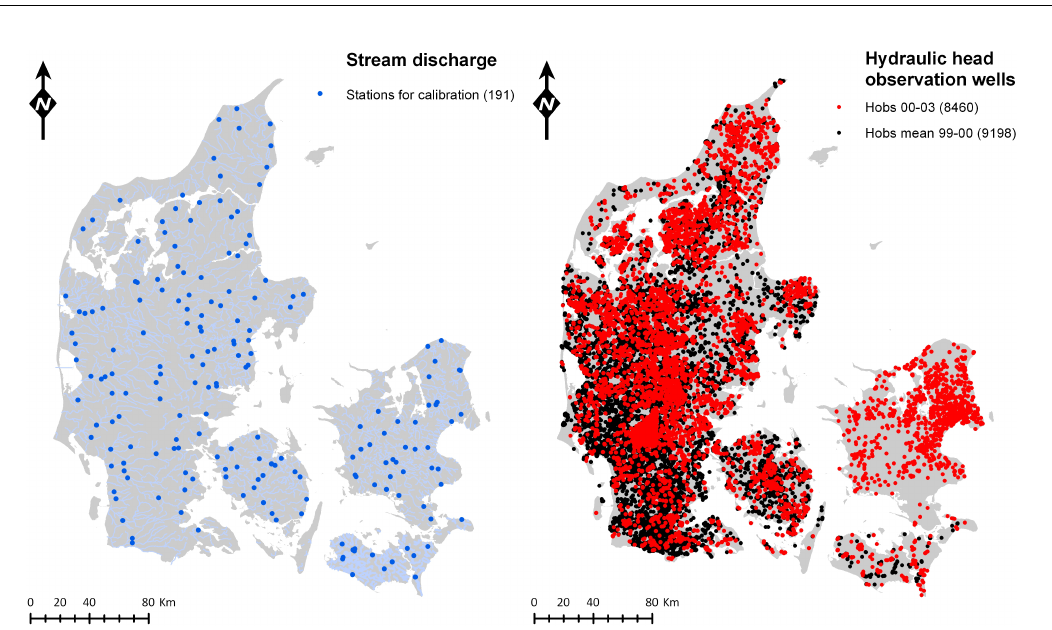
Fig. 5. All available discharge stations and observations wells for the calibration period 2000–2003.